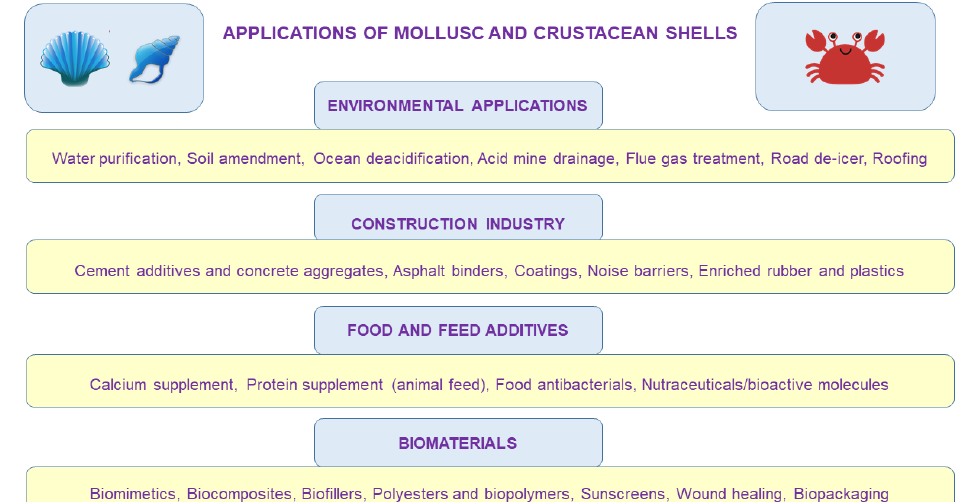
Figure 2. Conceptual diagram describing some of the numerous potential applications of waste mol- lusc and crustacean shells. To a larger or lesser extent, they are reutilized for applications in agricul- ture, medicine, chemical production, construction, environmental protection, cosmetic industry, food and feed industry, and a plethora of other (often niche) applications, which are being devel- oped by the